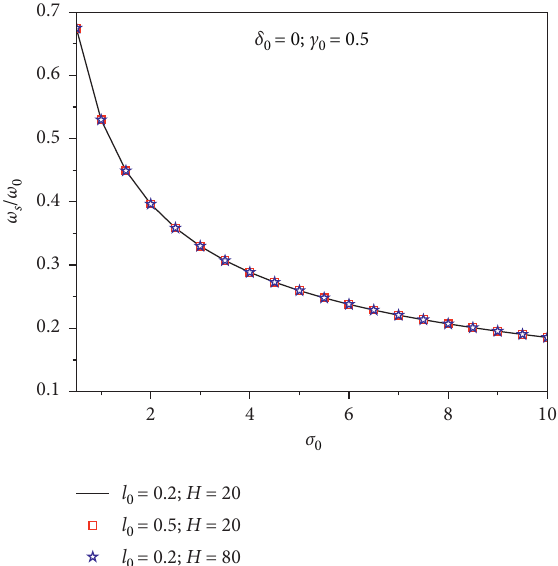
Figure 8: The variation in the ratio ω � 0 and c � 0.5. δ 0 0